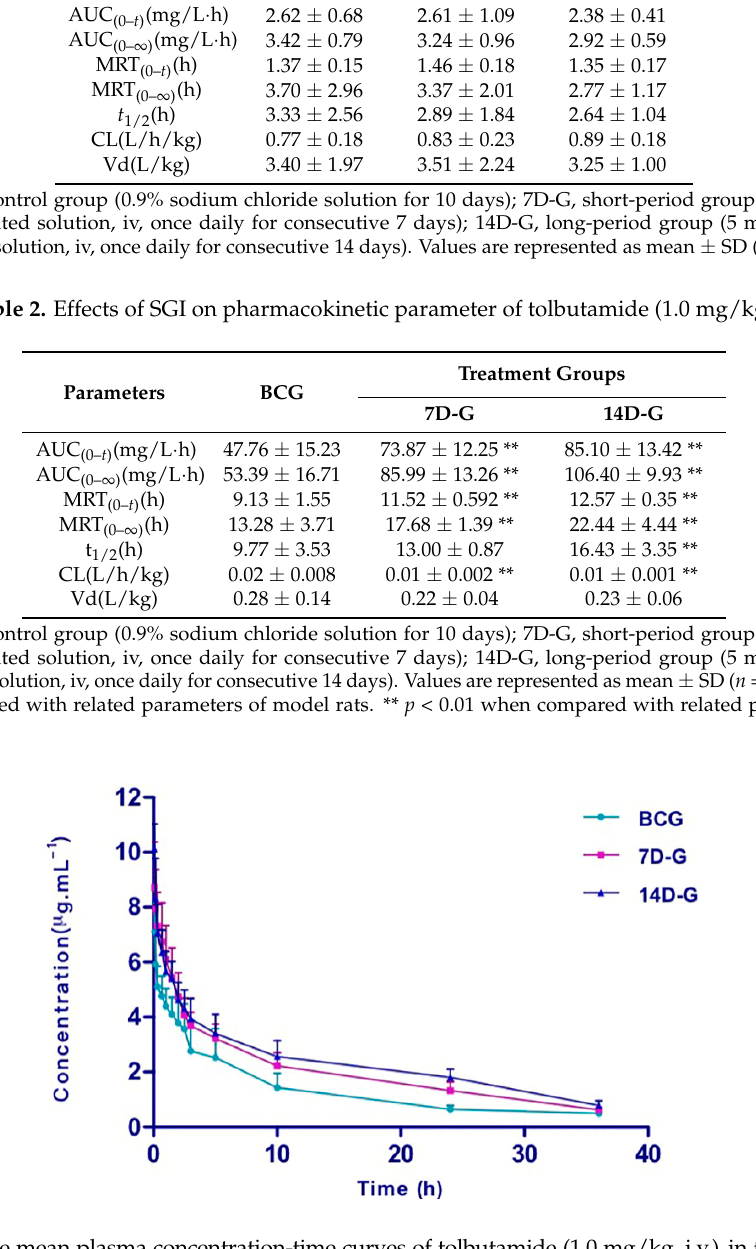
Table 1. Effects of Shenxiong glucose injection (SGI) on pharmacokinetic parameter of caffeine (1.0 mg/kg).